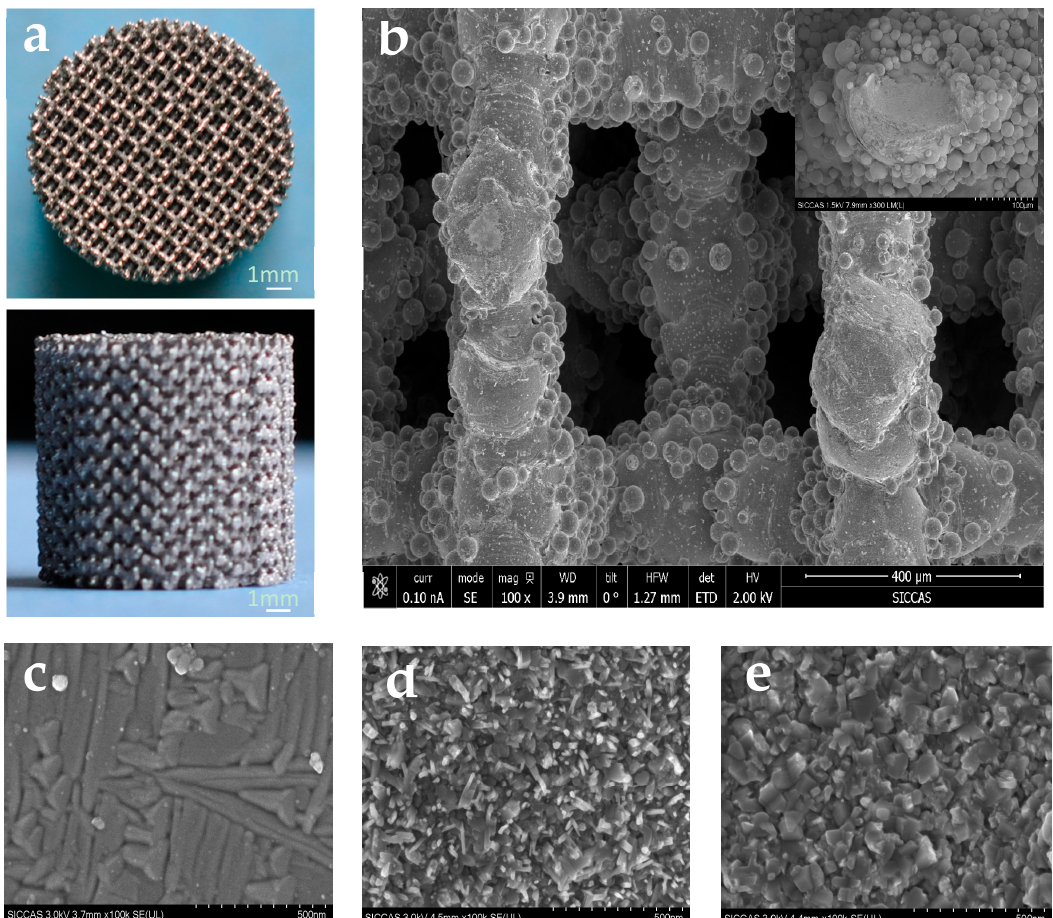
Figure 1. Overview of Ti-6Al-4V scaffolds ( a ); low-magnification view of scaffold struts showing macro pore sizes around 0.5 mm ( b ) together with an inserted high-magnification SEM image of the surface morphology of Ti-6Al-4V scaffold struts ( c ); BG-coated Ti-6Al-4V scaffold struts ( d ) and MBG-coated Ti-6Al-4V scaffold struts ( e ).